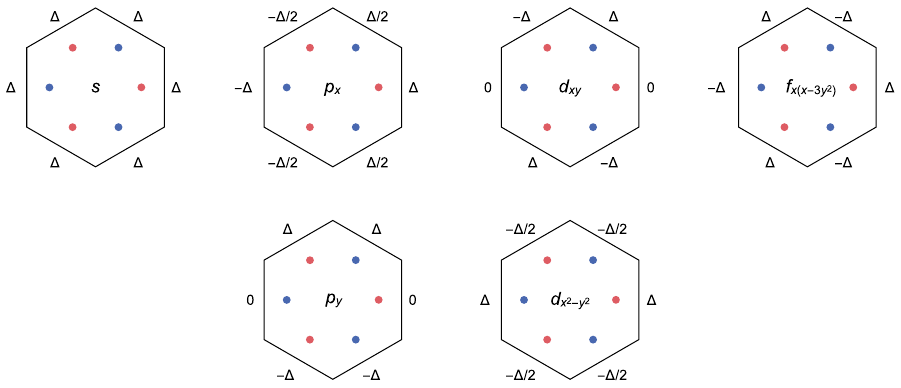
FIG. 9. SC pairing symmetries and order parameters at hot spots. Note that the order parameters are not normalized for each